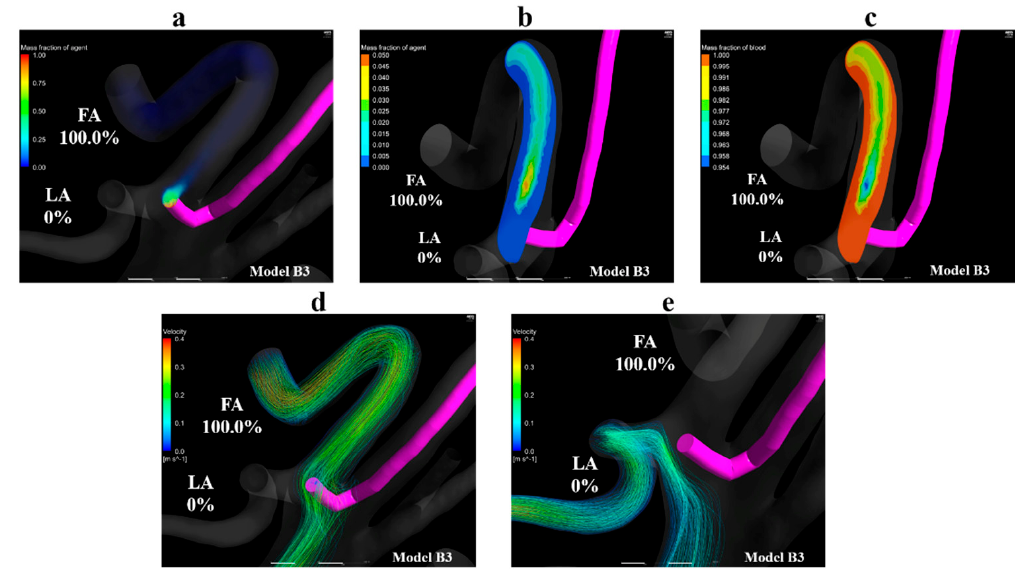
Figure 11. Volume-rendering images, contour plots, and streamlines in model B3. ( a ) Volume-rendering image of an anticancer agent in model B3, ( b ) contour plots of the mass fraction of agent in the linguofacial trunk in model B3, ( c ) contour plots of the mass fraction of blood in the linguofacial trunk in model B3, ( d ) streamlines towards the FA in model B3, ( e ) streamlines toward the LA in model B3. The number of figures shows the distribution rate of the agent. FA, facial artery; LA, lingual artery.